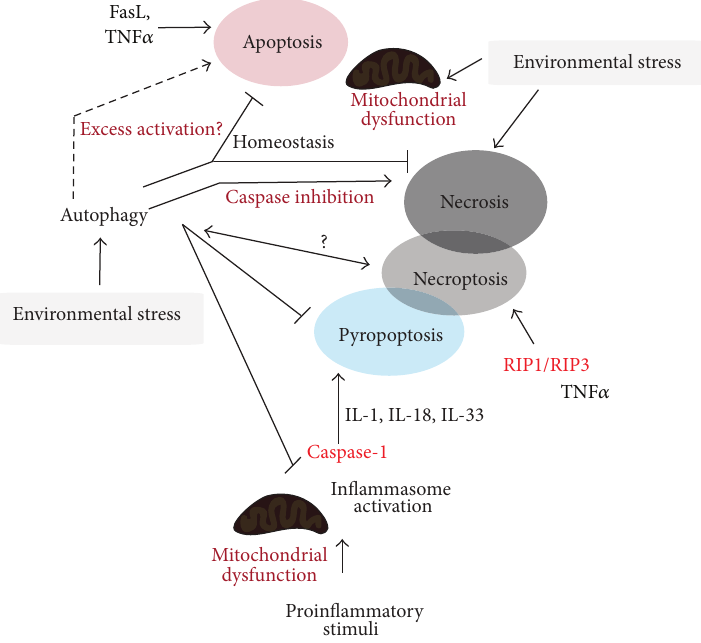
Figure 3: Autophagy has a complex relationship with various modes of cell death, including regulated (e.g., apoptosis, pyroptosis, and necroptosis) and catastrophic (e.g., necrosis) types of cell death. Autophagy has been implicated in association with caspase-independent cell death in apoptosis-compromised cells leading to necrosis and necroptosis. Furthermore, autophagy has been implicated as an inhibitor of both apoptosis and necrosis by preserving cellular functions, removing toxic debris, and maintaining cellular energy charge. Nevertheless, proapoptoticrolesofautophagyhavealsobeenreported.Proinflammatorystimulicanactivateinflammasome-dependentcaspase-1activation leading to proinflammatory cytokines maturation. Excess activation of this pathway can lead to pyroptotic cell death. Mitochondrial dysfunction plays a key role in both apoptosis signaling and the activation of the inflammasome pathway. Autophagy can influence these pathways through modulation of the mitochondrial pool. The relationships between autophagy and necroptosis or pyroptosis require further